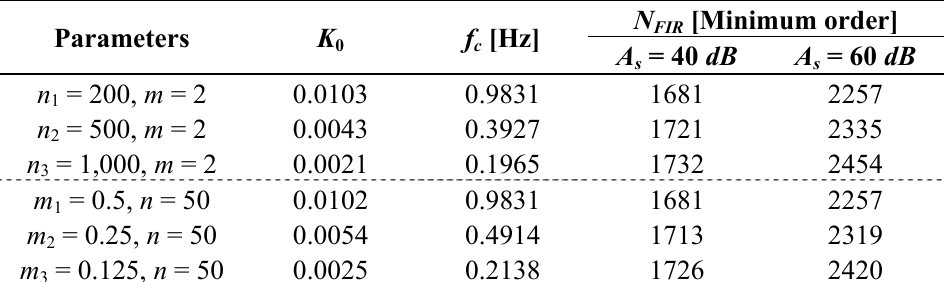
Table 5. Values of K